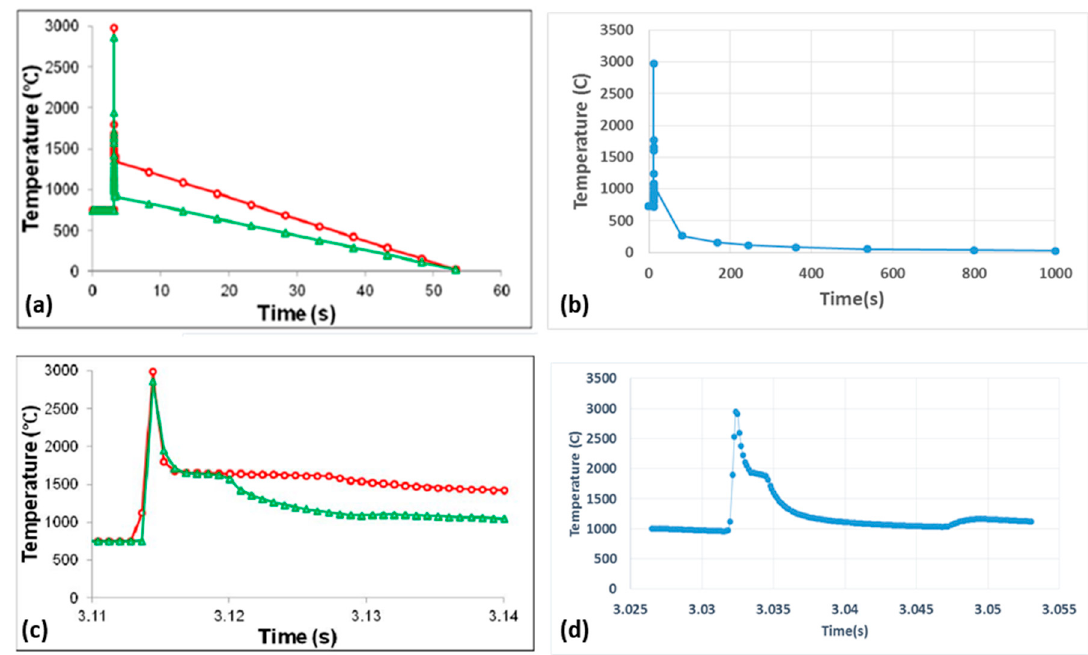
Figure 12. ( a ) Simulation results of temperature history after final cooling (Shen & Chou [14]) ( b ) Zoomed-in view of simulation results of temperature history after final cooling (Shen & Chou [14]) ( c ) Current model simulation results of temperature history after final cooling ( d ) Zoomed-in view of current model simulation results of temperature history after final.